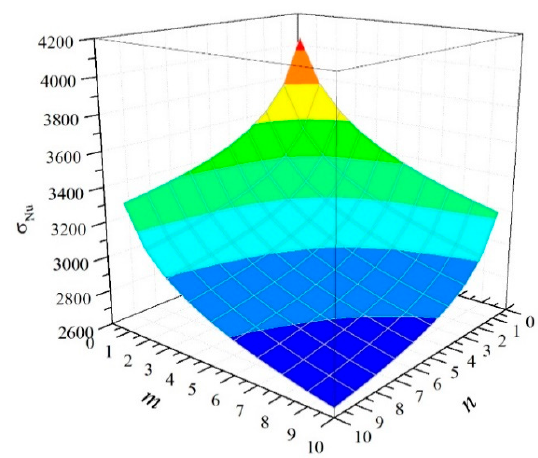
Figure 7. Relationship between mean strength and system size.